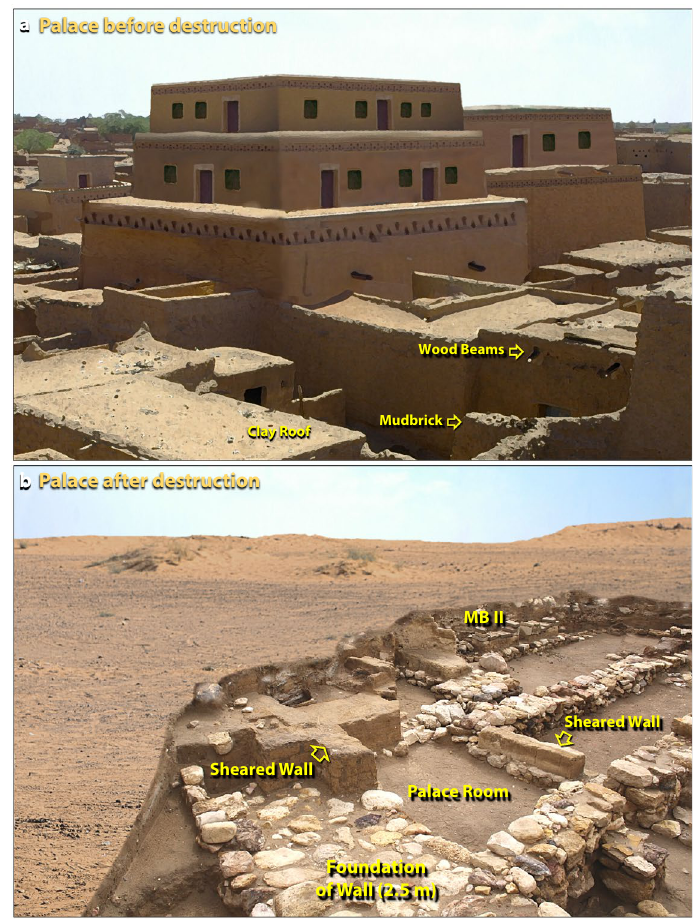
Figure 2. Catastrophic leveling of the palace at TeH. ( a ) Artist’s evidence-based reconstruction of the 4-to-5-story palace that was ~ 52 m long and 27 m wide before its destruction. ( b ) Artist’s evidence-based reconstruction of palace site on upper tall, along with modern excavation. “MB II” marks the top of 1650-BCE Middle Bronze rubble. Note that the field around the excavation is essentially flat, unlike the view in panel ‘ a ’. Originally, parts of the 4-story palace were ~ 12 + m tall, but afterward, only a few courses of mudbricks remain on stone foundations, labeled as “wall remnants”. Part of the foundation of the massive wall around the palace is at the bottom. Debris from between sheared walls has been removed by excavation. A comparison of panel ‘ a ’ to panel ‘ b ’ shows that millions of mudbricks from the upper parts of the palace and other buildings are